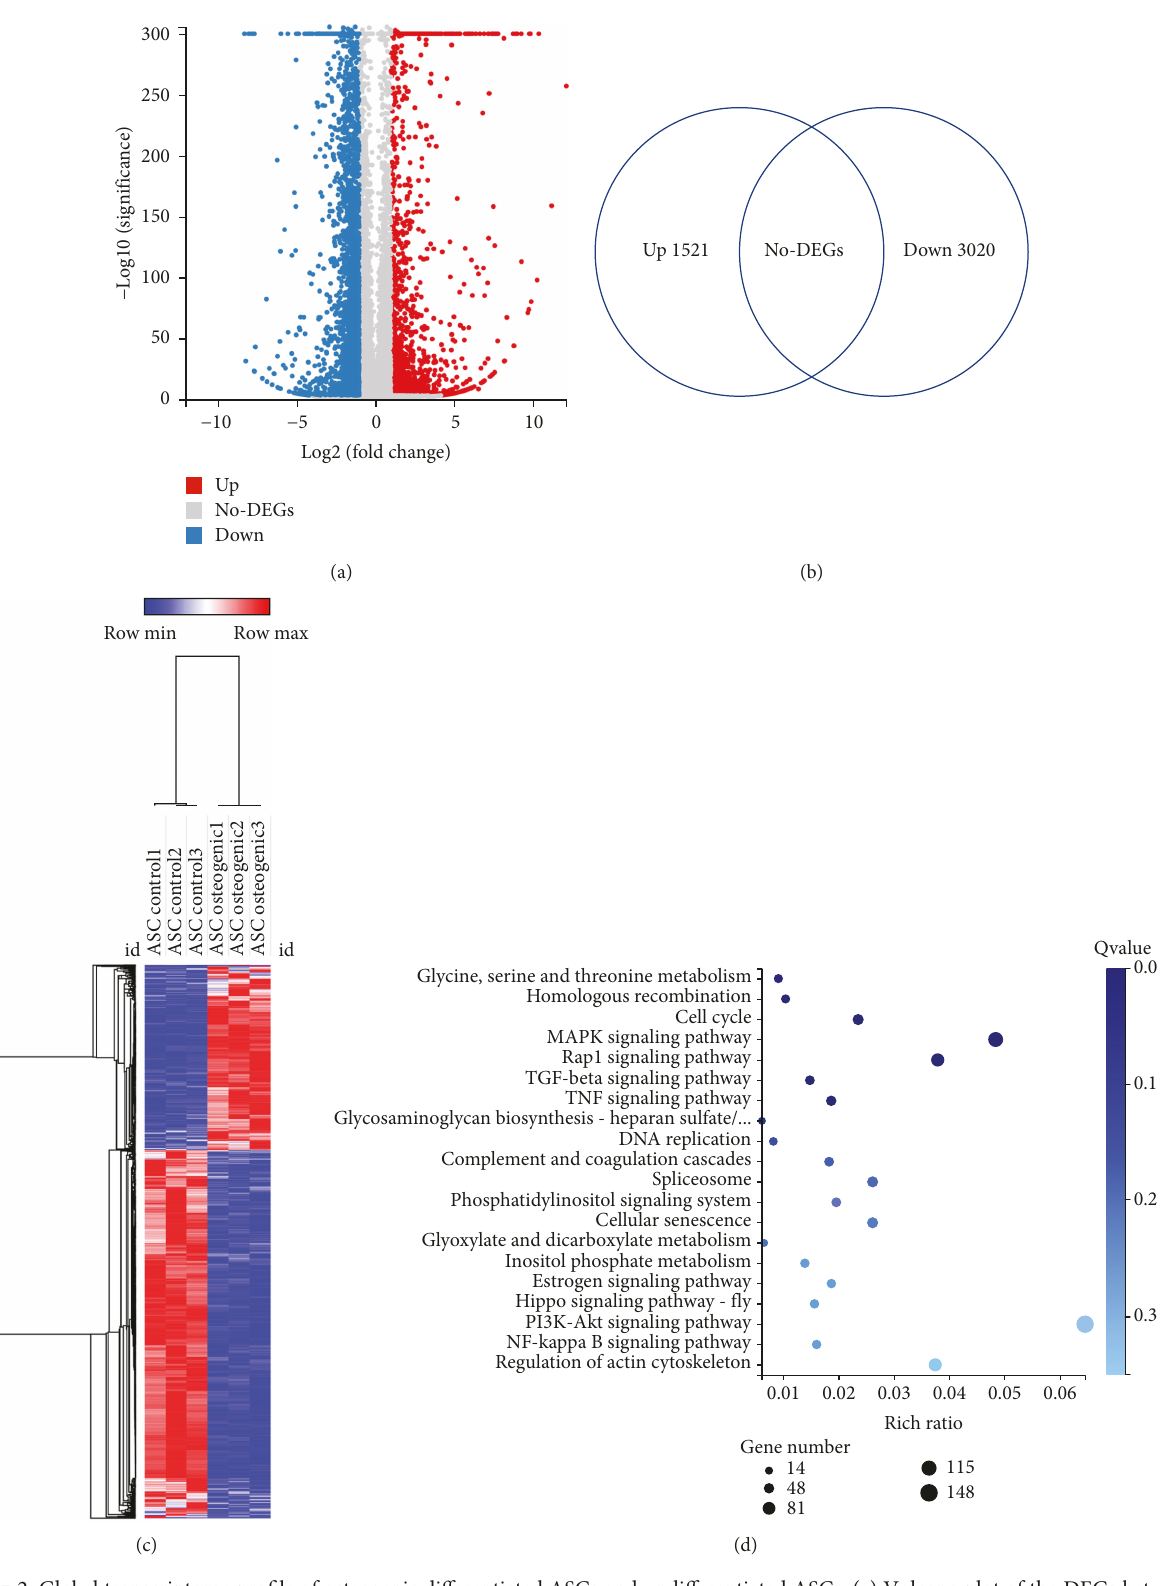
Figure 2: Global transcriptome pro fi le of osteogenic di ff erentiated ASCs and undi ff erentiated ASCs. (a) Volcano plot of the DEGs between osteogenic di ff erentiated ASCs and undi ff erentiated ASCs. Totally, 1521 upregulated and 3020 downregulated genes were identi fi ed. (b) Heat map of the DEGs between osteogenic di ff erentiated ASCs and undi ff erentiated ASCs. (c) KEGG pathway analysis of the DEGs between osteogenic di ff erentiated ASCs and undi ff erentiated